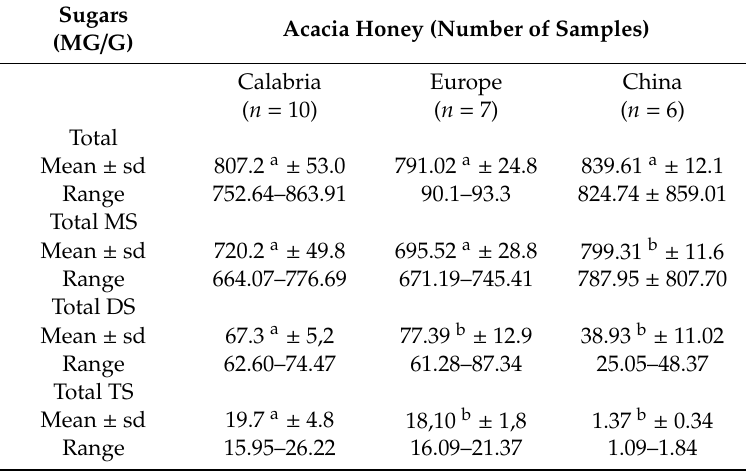
Table 6. Sugars amount in the acacia honeys of Calabria vs. China and